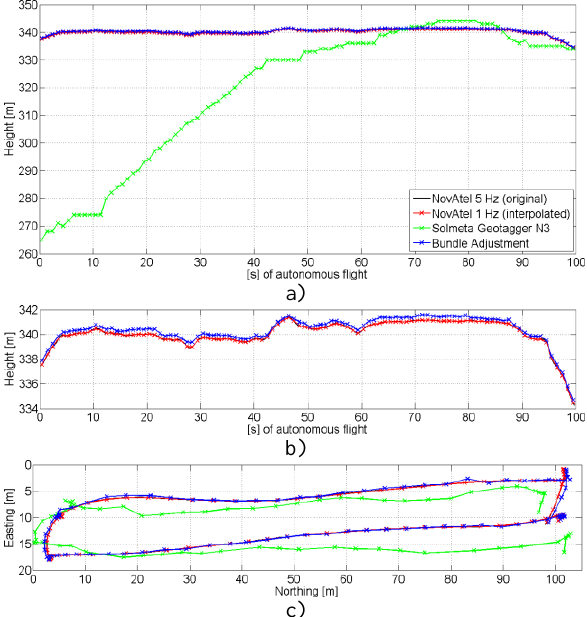
Figure 4. Positions computed; a) height, b) height (without geotagger), and c) horizontal position